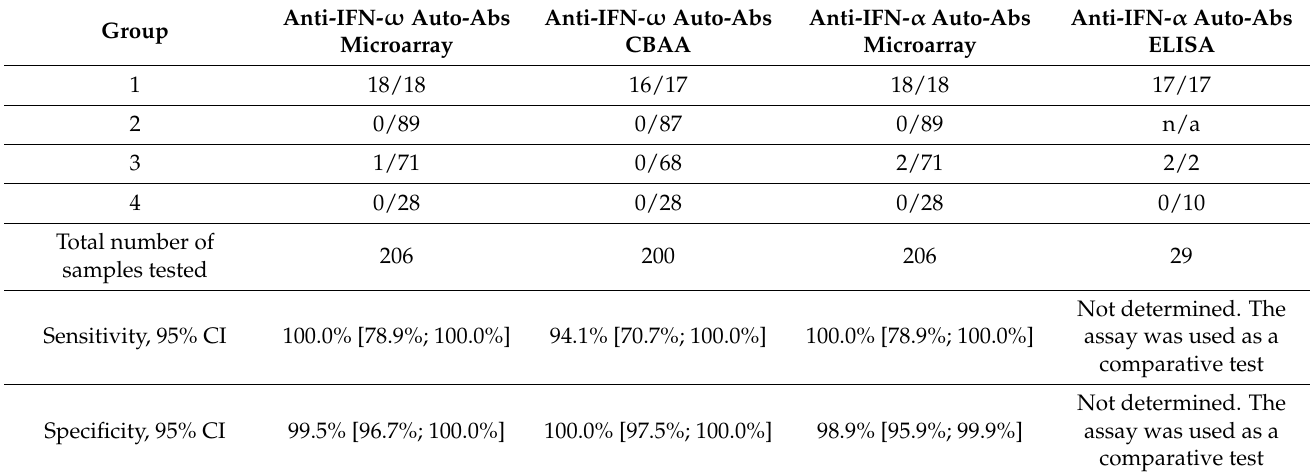
Table 2. Anti-IFN-I positive patients by group (n/n total), sensitivity and specificity of